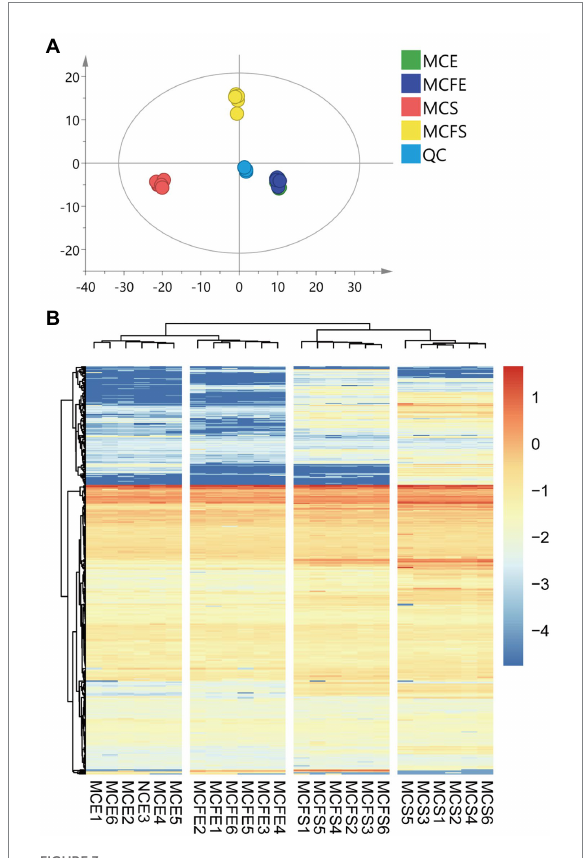
FIGURE 3 Principal component analysis (PCA) of metabolic profiles in all samples, with six replicates per treatment (A) ; Cluster heatmap of metabolite content in different samples (B) . The x-axis represents six replicate cultures of each of the four treatment groups, the y-axis represents individual metabolites of the groups. Color blocks represent the relative concentration of metabolites at the corresponding positions. MCE, MC-producing strain at exponential phase; MCFE, MC-free strain at exponential phase; MCS, MC-producing strain at stationary phase; MCFS, MC-free strain at stationary